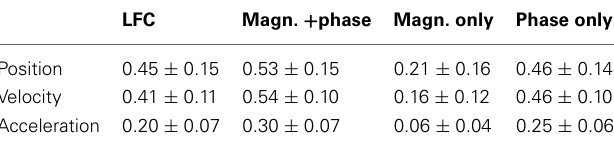
Table 2 | Peak decoding accuracies. CC values (mean ± std over the 3 × 30 movement validation folds of all 3 subjects), at the optimal time offset defined for each subject individually.